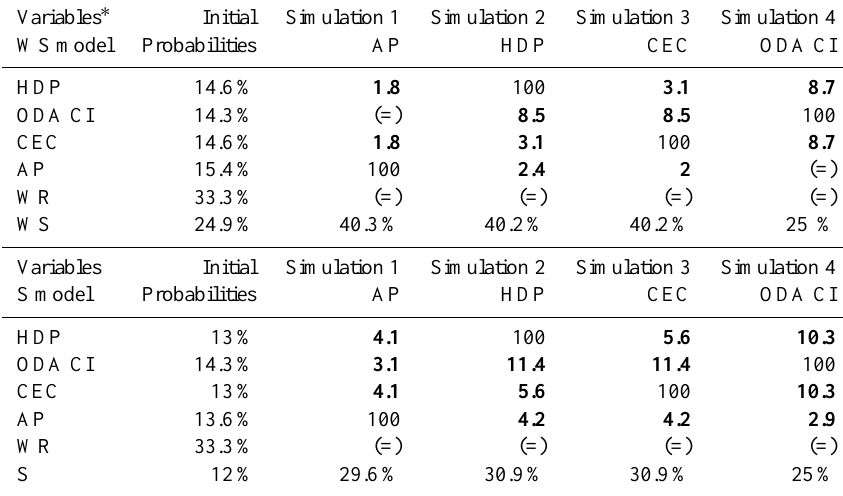
Table 9. Profile 5: water supply and sanitation